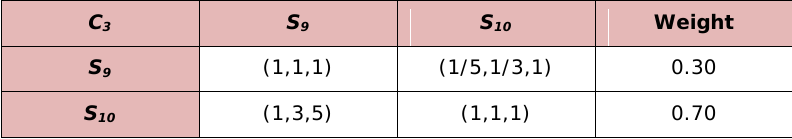
Table 5. “Fuzzy comparison matrix of the sub-criteria with respect to use”.